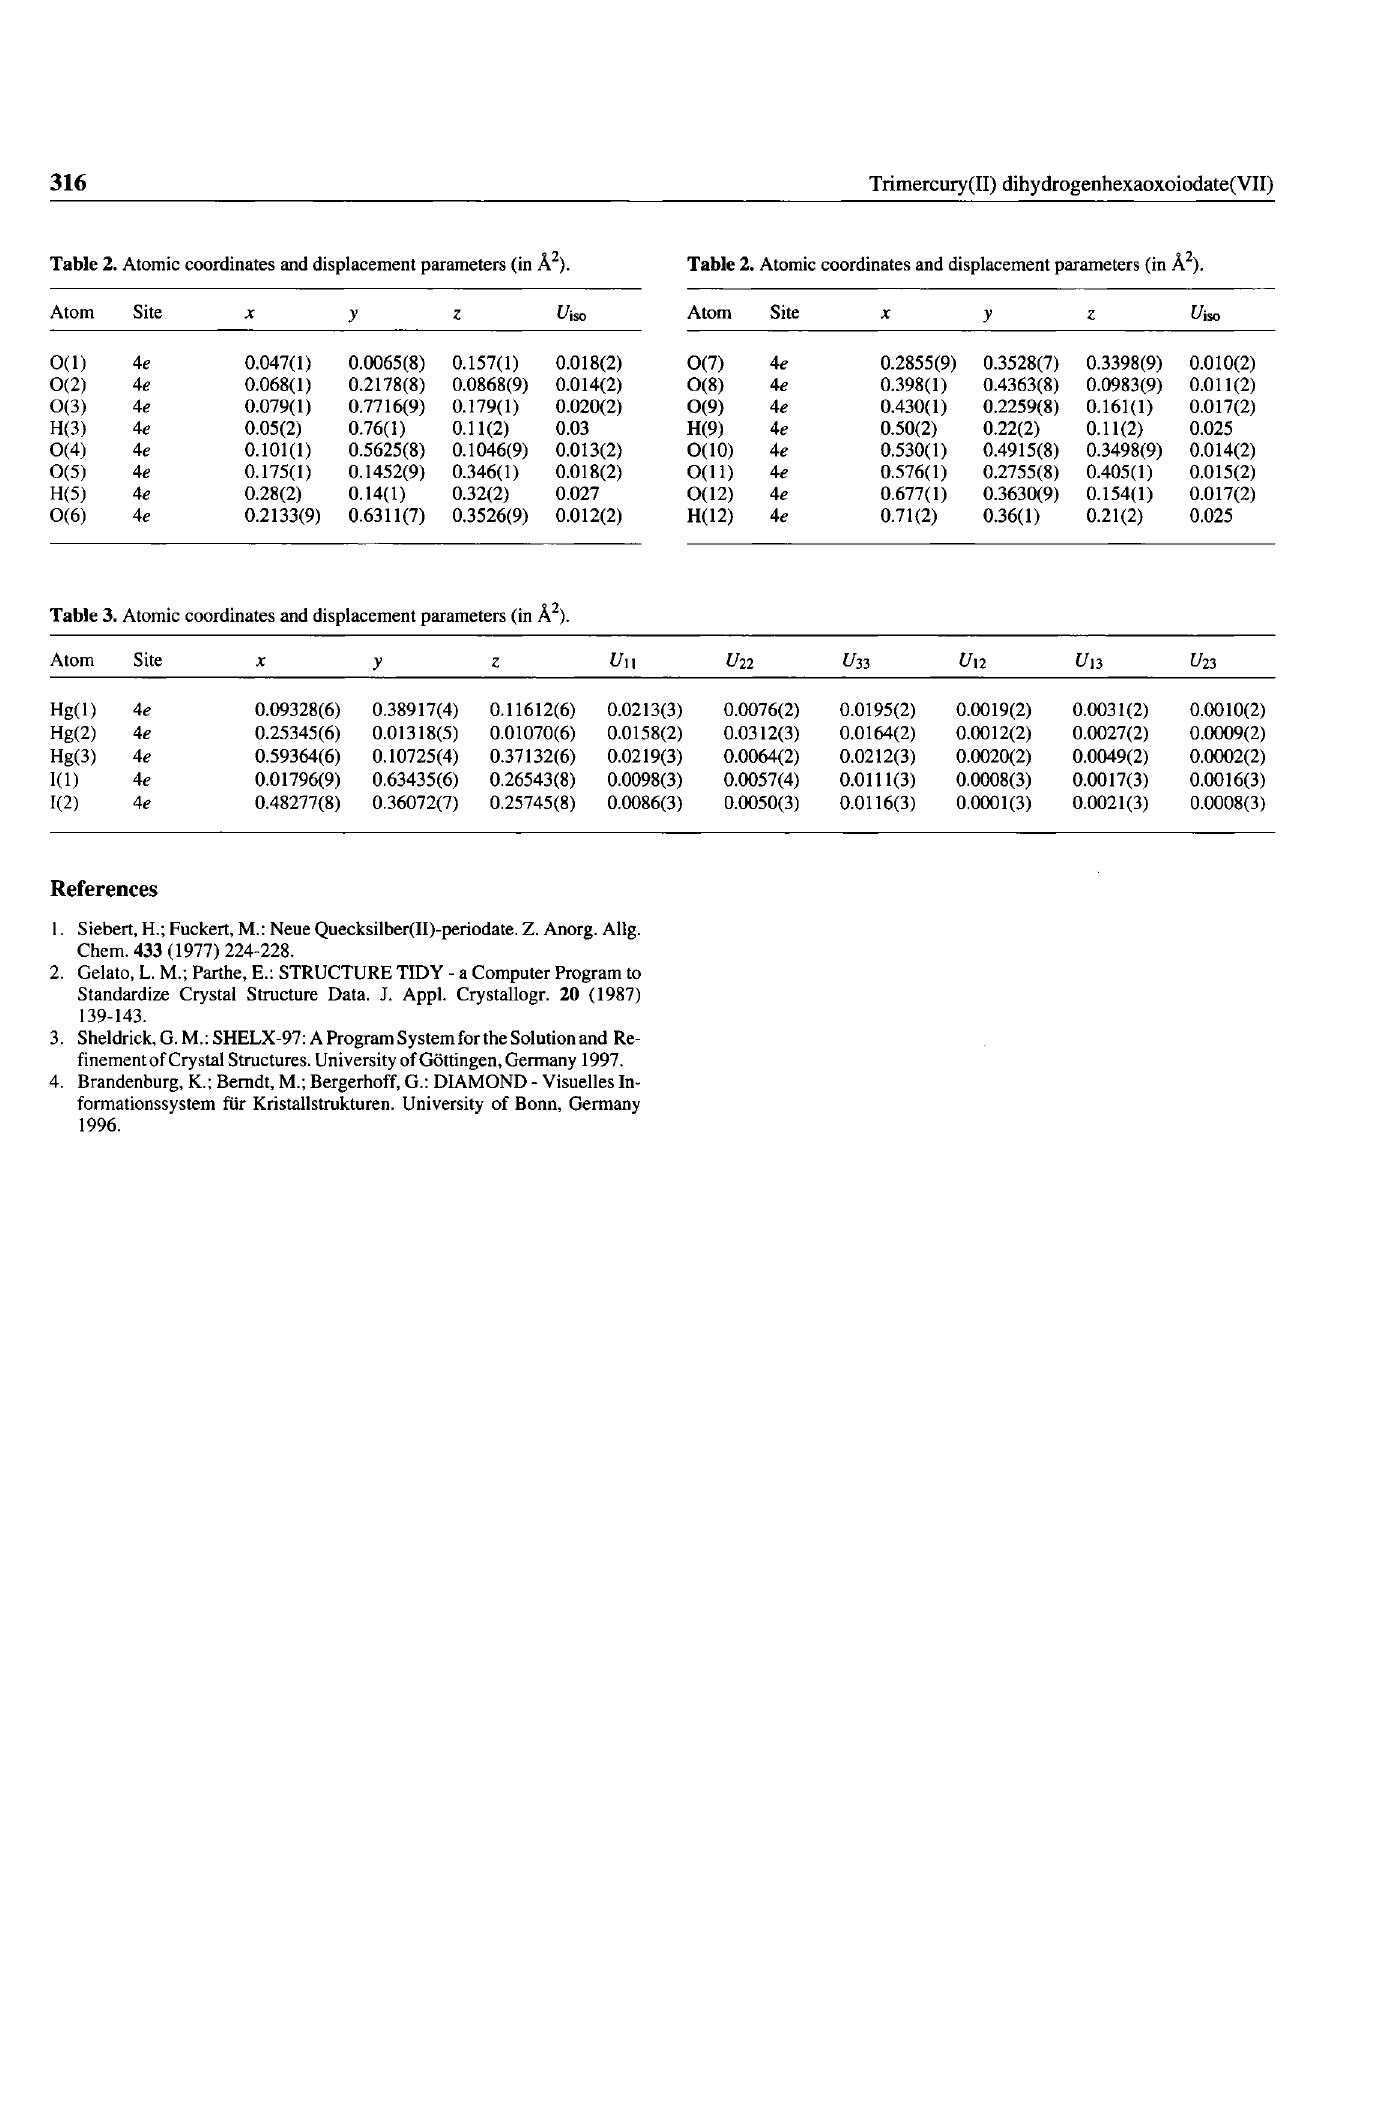
Table 3. Atomic coordinates and displacement parameters (in Ä 2